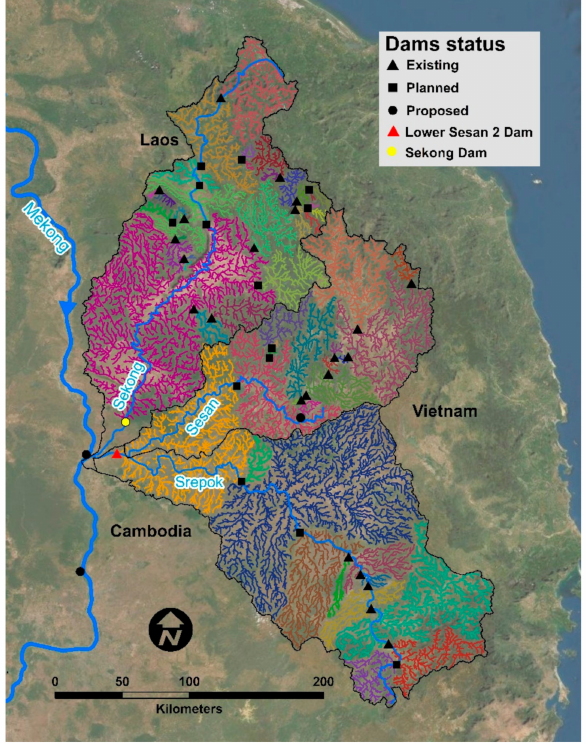
Figure 7. Fragmented stream segments, shown with different colors, in the 3S Basin from existing, planned, and proposed